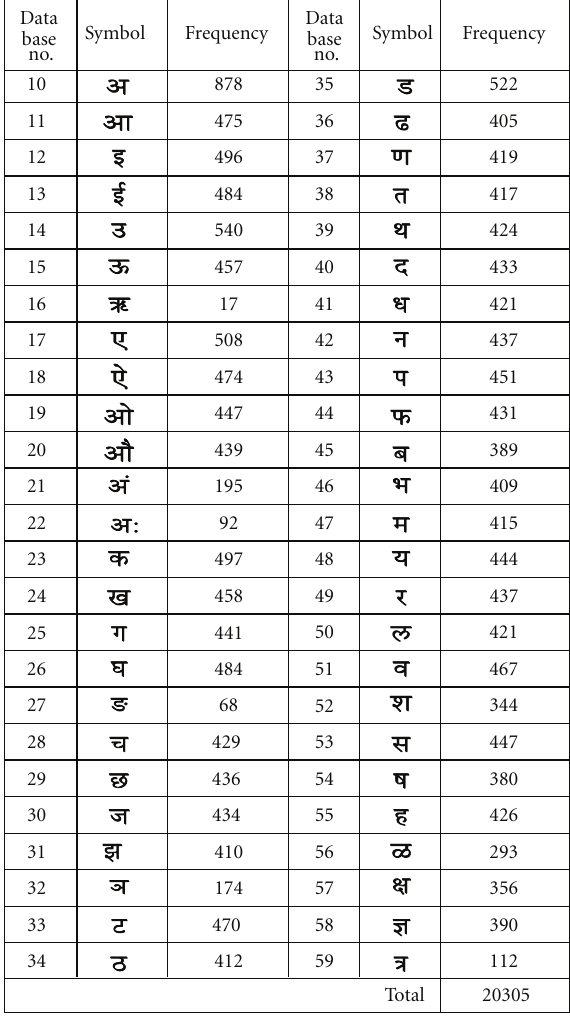
Figure 8: Devnagari Character